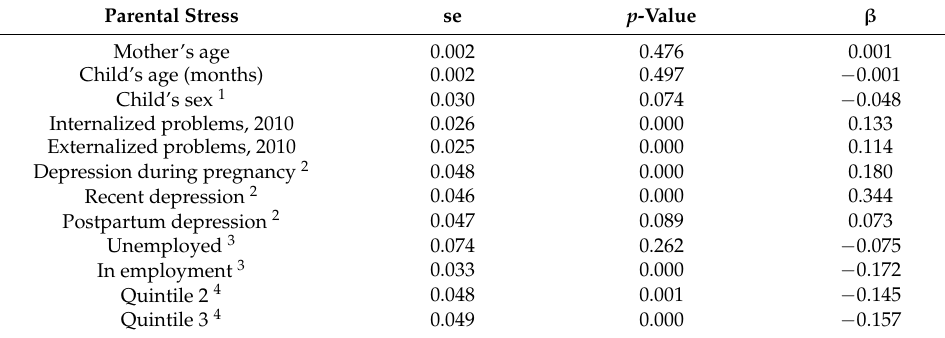
Table 4. Set of predictors of parental stress.